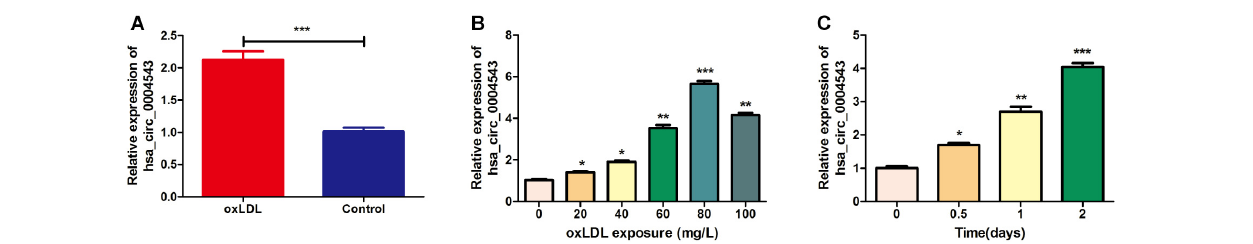
FIGURE 1 | The expression of hsa_circ_0004543 is upregulated in HUVECs treated with oxLDL. (A) RT-qPCR analysis was used to detect hsa_circ_0004543 expression in HUVECs treated with oxLDL (80 mg/L). (B) Hsa_circ_0004543 expression in HUVECs was increased following treatment with oxLDL. (C) The relative expression of hsa_circ_0004543 in HUVECs treated with 80 mg/L oxLDL was increased with time. * p < 0.05, ** p < 0.01, *** p < 0.001.